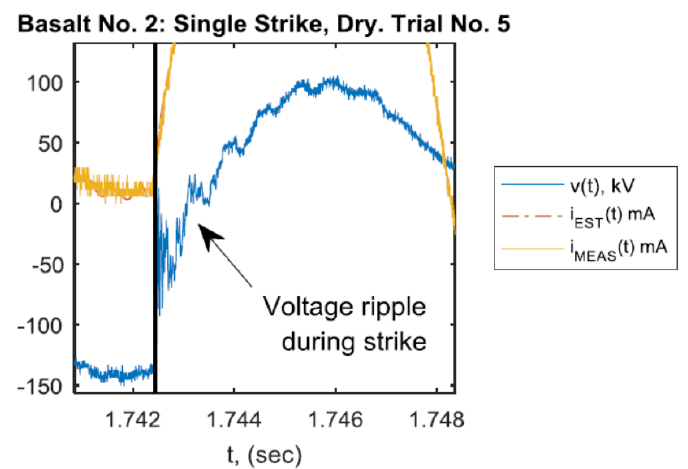
Figure 2. Close-up of voltage and current waveforms around fault onset, referred to the secondary (150 kV) side of the transformer, for sample A2, trial 5. The voltage ripple introduced non-60-Hz oscillations that were used to identify fault onset using a wavelet transformation.